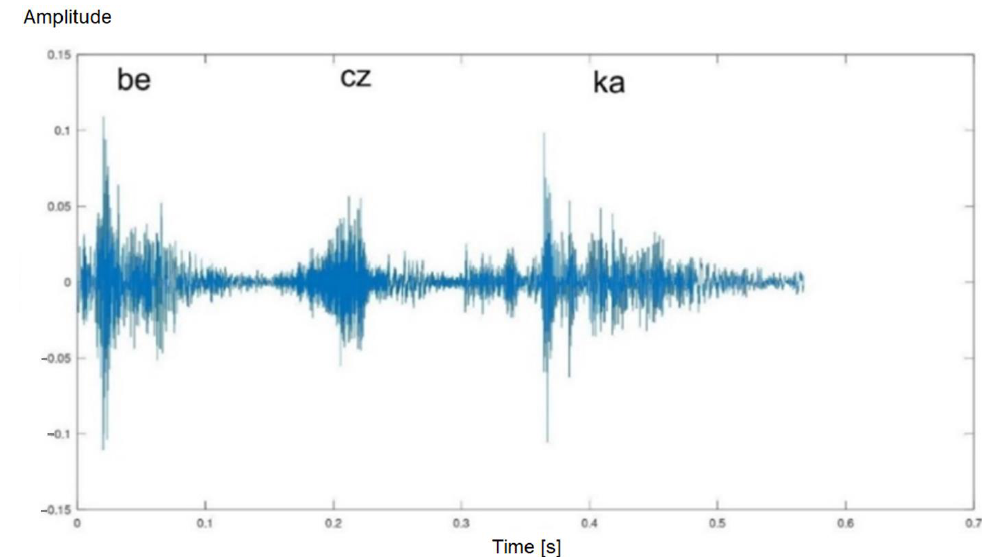
Figure 4. Time waveform of the word “beczka” (eng. a barrel)—laryngectomised man. Three phonetic segments are visible.